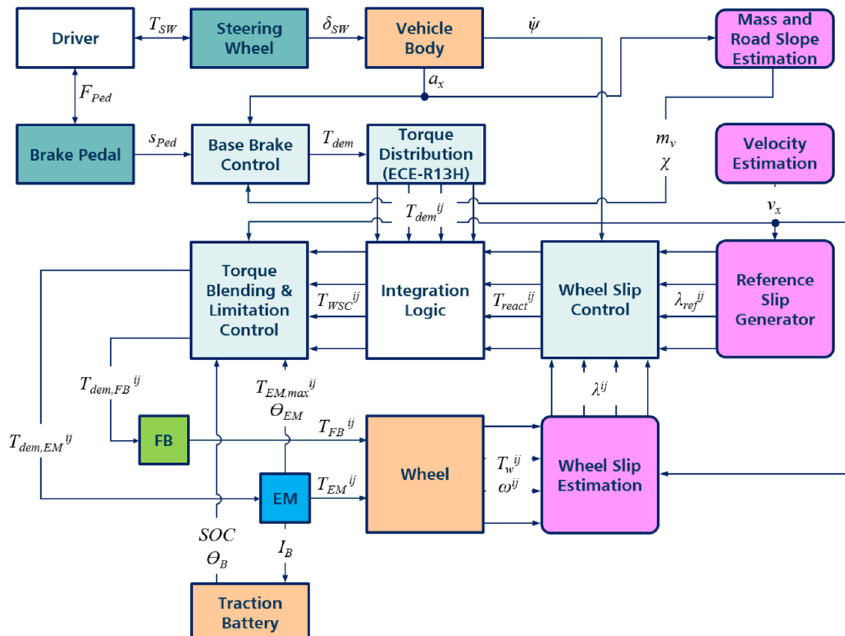
Figure 5. Block scheme of the developed and used integrated control.